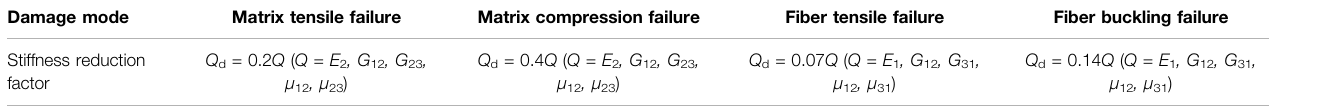
TABLE 1 | Stiffness degradation model of GFRP.